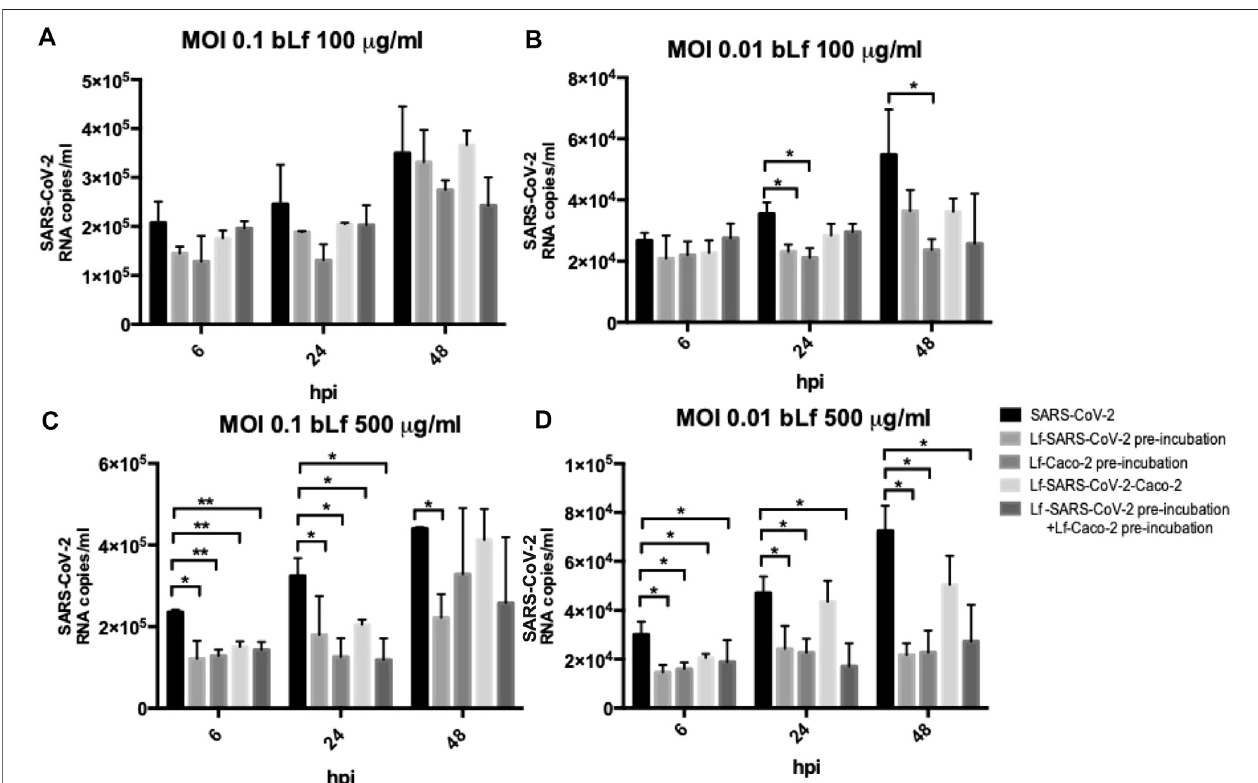
FIGURE 2 | RNA copies/ml of SARS-CoV-2 observed in supernatants of Caco-2 cells infected at multiplicity of infection (MOI) of 0.1 (A,C) and 0.01 (B,D) in the presence or absence of100 μ g/ml (A,B) and 500 μ g/ml (C,D) ofbovine lactoferrin (bLf) according to the following experimental procedures: i) control: untreated SARS- CoV-2 and Caco-2cells; ii)bLfpreincubatedwithSARS-CoV-2inoculum for1 hat 37 ° Cbefore cellinfection; iii)cellspreincubatedwithbLf for1 hat 37 ° CbeforeSARS- CoV-2 infection; iv) bLf added together with SARS-CoV-2 inoculum during the adsorption step; and v) virus and cells separately preincubated with bLf for 1 h at 37 ° C before infection. Viral supernatant samples were harvested at 6, 24, and 48 hours postinfection (hpi). Viral loads were ascertained with quantitative rRT-PCR. Data represent the mean values of three independent experiments. Error bars: standard error of the mean. Statistical signi fi cance is indicated as follows: *: p < 0.05, **: p < 0.001 (Unpaired student ’ s t